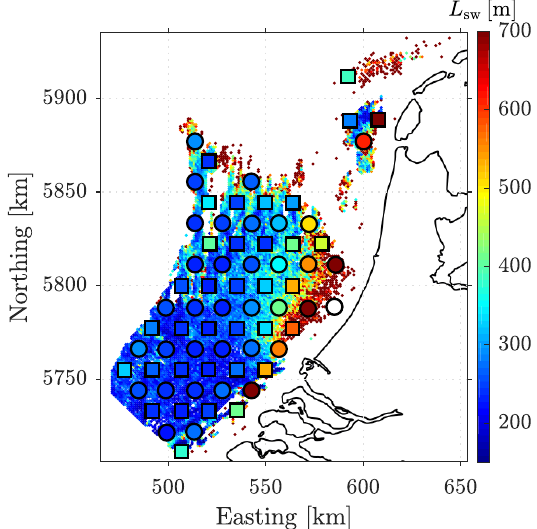
Figure 6. Modeled sand wave lengths L mod sw using the calibrated S and T w values, plotted onto the background of observed sand wave lengths L obs sw [12,33]. Circles (squares) are the locations used for calibration (validation). White markers indicate locations for which the model predicts no sand waves to